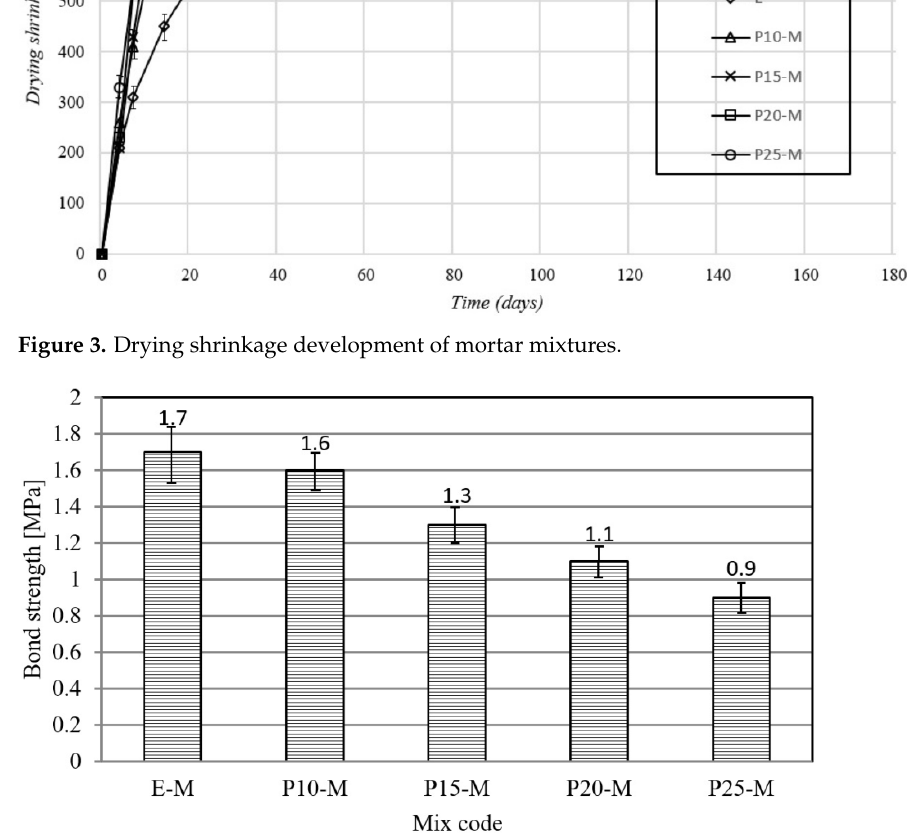
Figure 4. Adhesion between mortar and a concrete substrate.